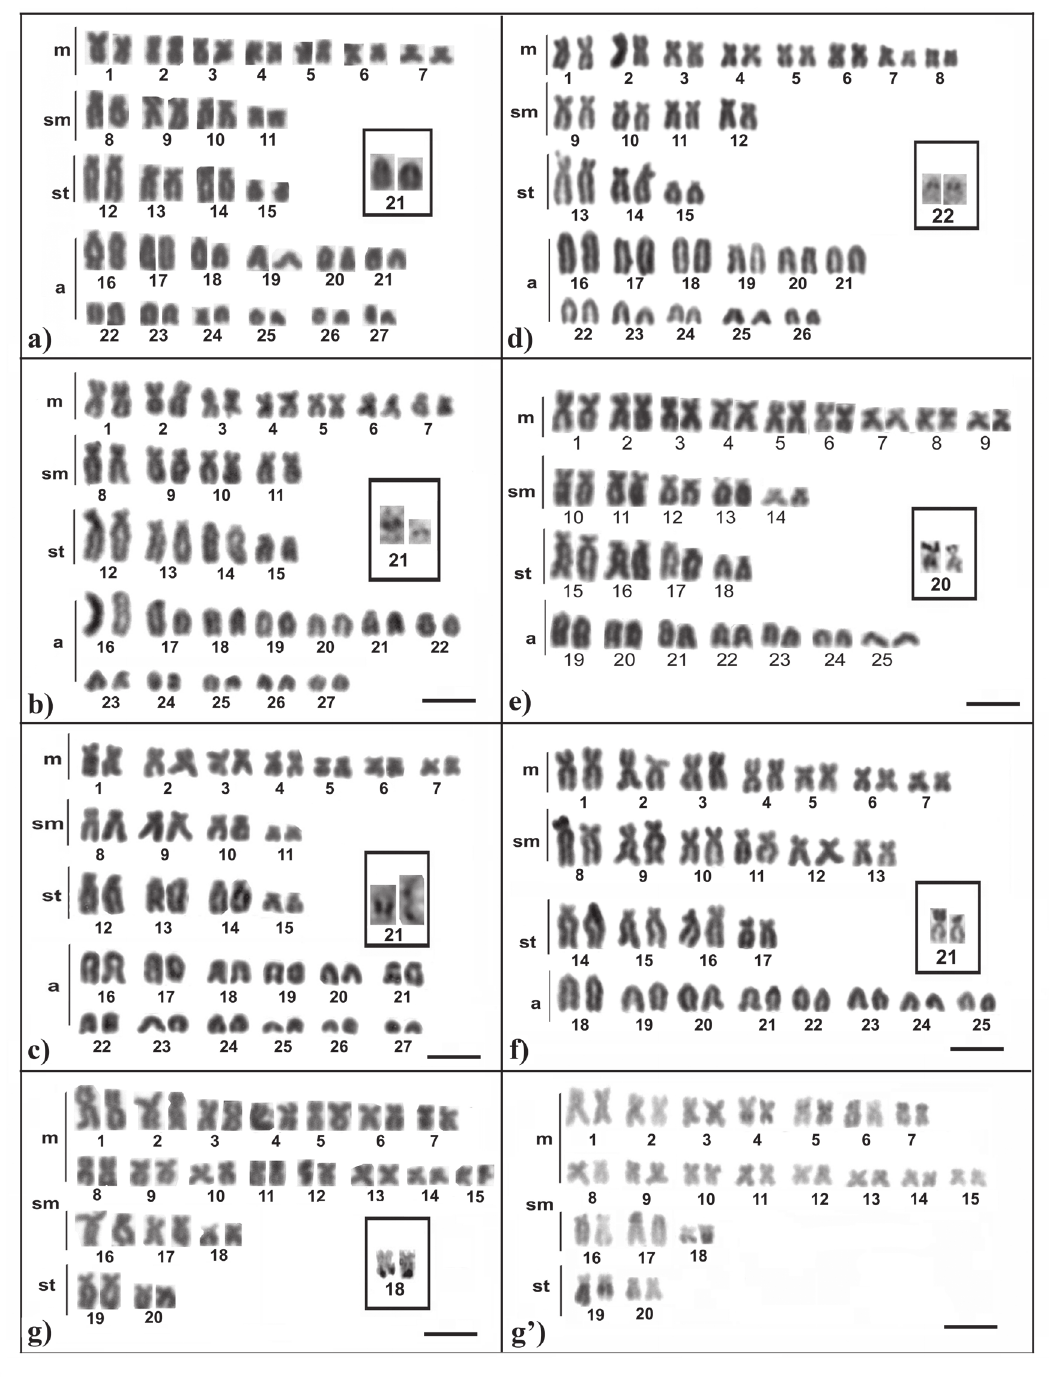
Fig. 2. Karyotypes of Ancistrus with AgRONs in boxes ( a-g ); C band of Ancistrus sp. 13 ( g’ ). Bars 10 μ